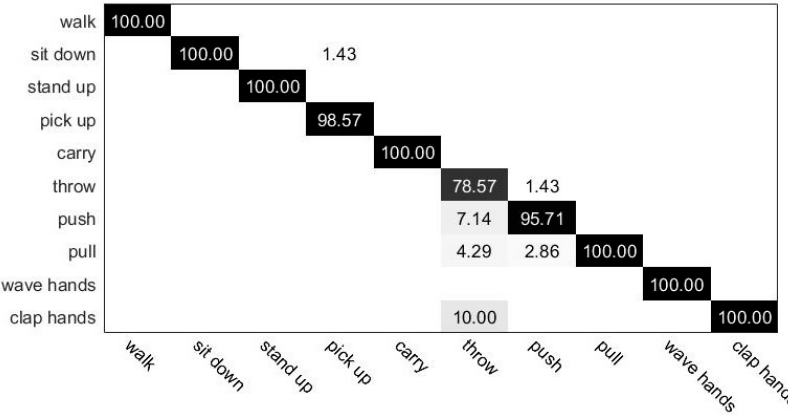
Figure 7. Confusion matrix of our proposed method in UTKinect-Action3D dataset.